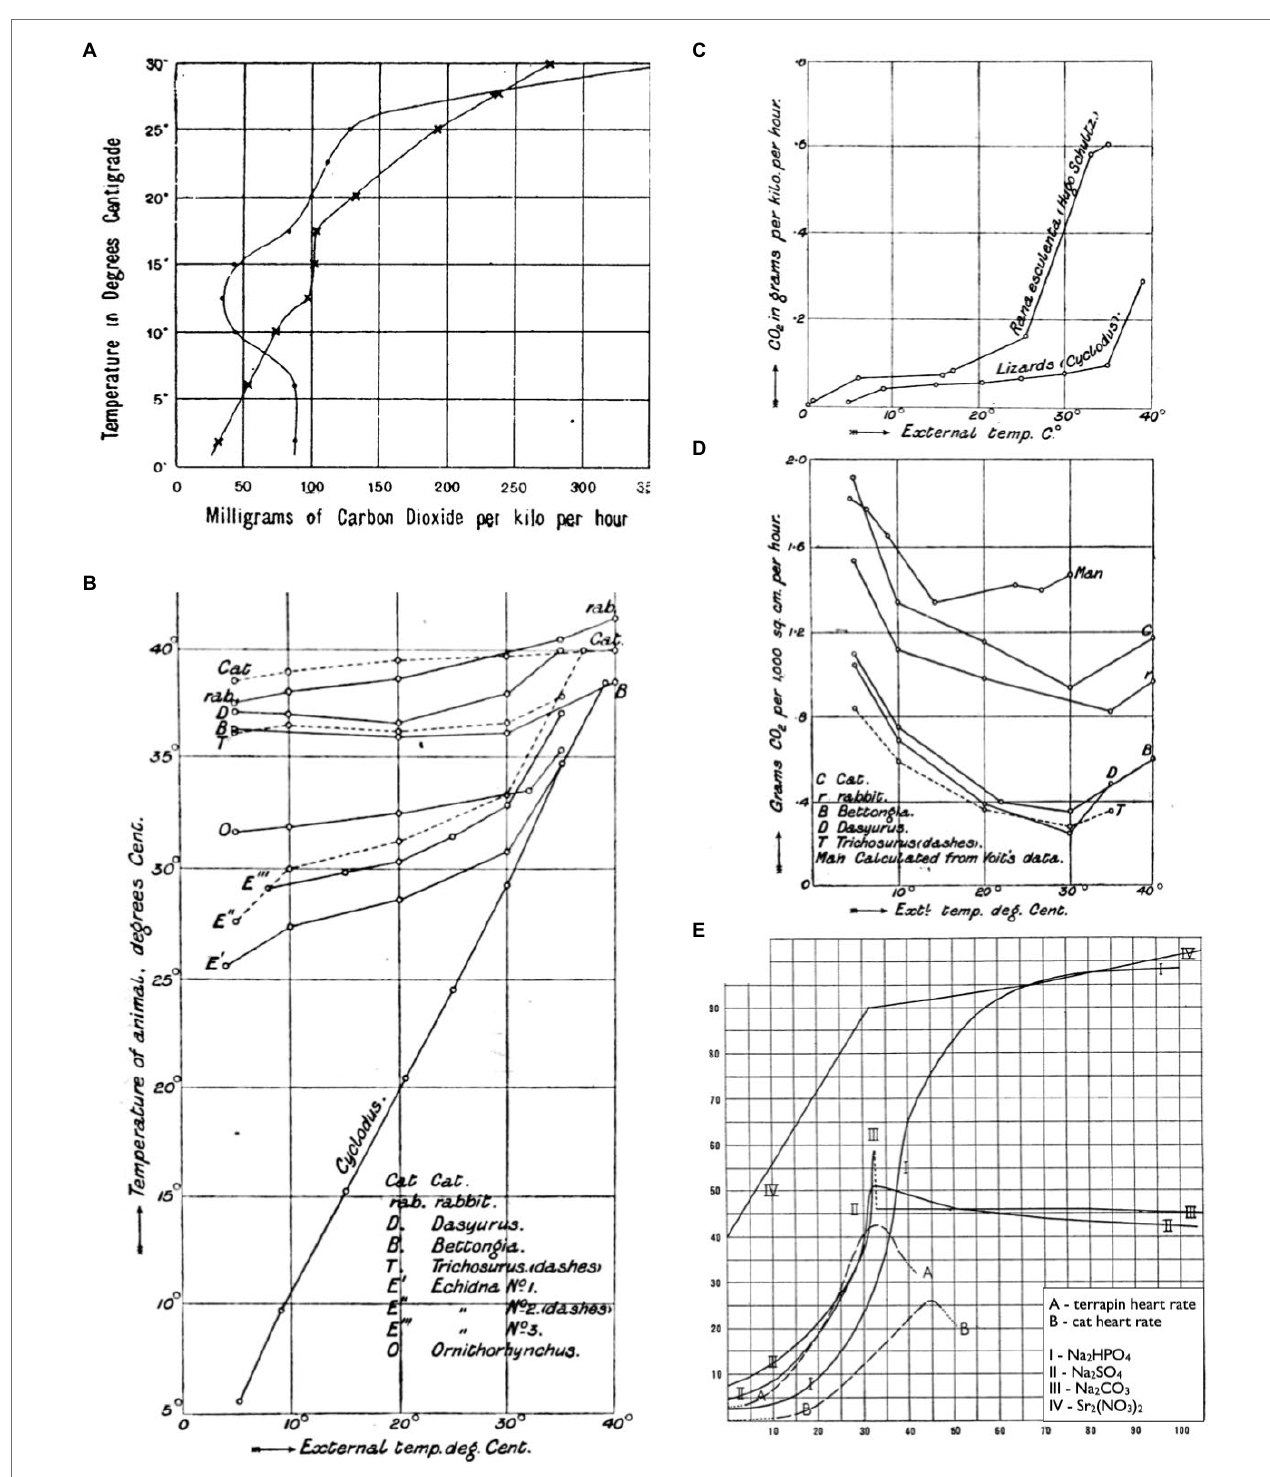
FIGURE 1 | Thermal reaction norms as early examples of performance curves. CO 2 -production of a frog warmed from 2 to 32 ° C, then cooled back down to 2 ° C again the following day ( A ; reprinted from Vernon, 1894). Body temperatures of thermoregulators and thermoconformers respond differently to changes in ambient temperature ( B ; reprinted from Martin, 1903). CO 2 -production of thermoconformers (C) and thermoregulators (D) reveal that different metabolic properties underlie each evolutionary strategy (reprinted from Martin, 1903). Thermal sensitivities of heart rates for terrapin ventricle and a cat heart alongside thermal solubility curves for Na 2 HPO 4 , Na 2 SO 4 , Na 2 CO 3 , and Sr 2 (NO 3 ) 2 ( E ; adapted from Snyder,